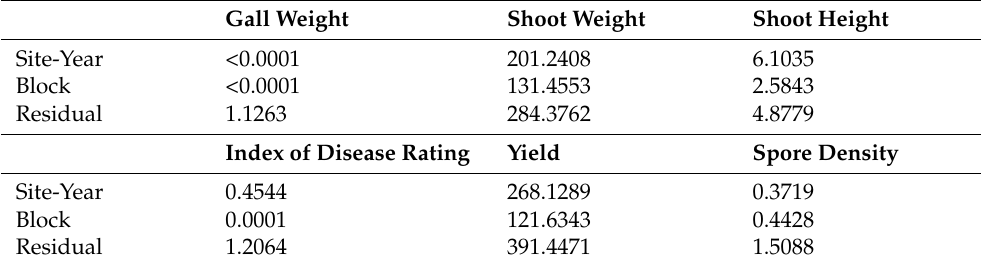
Table A1. Variance components (standard deviations) for Site-Year and Block terms (random inter- cepts) and residuals, showing the relative variance accounted within each term.